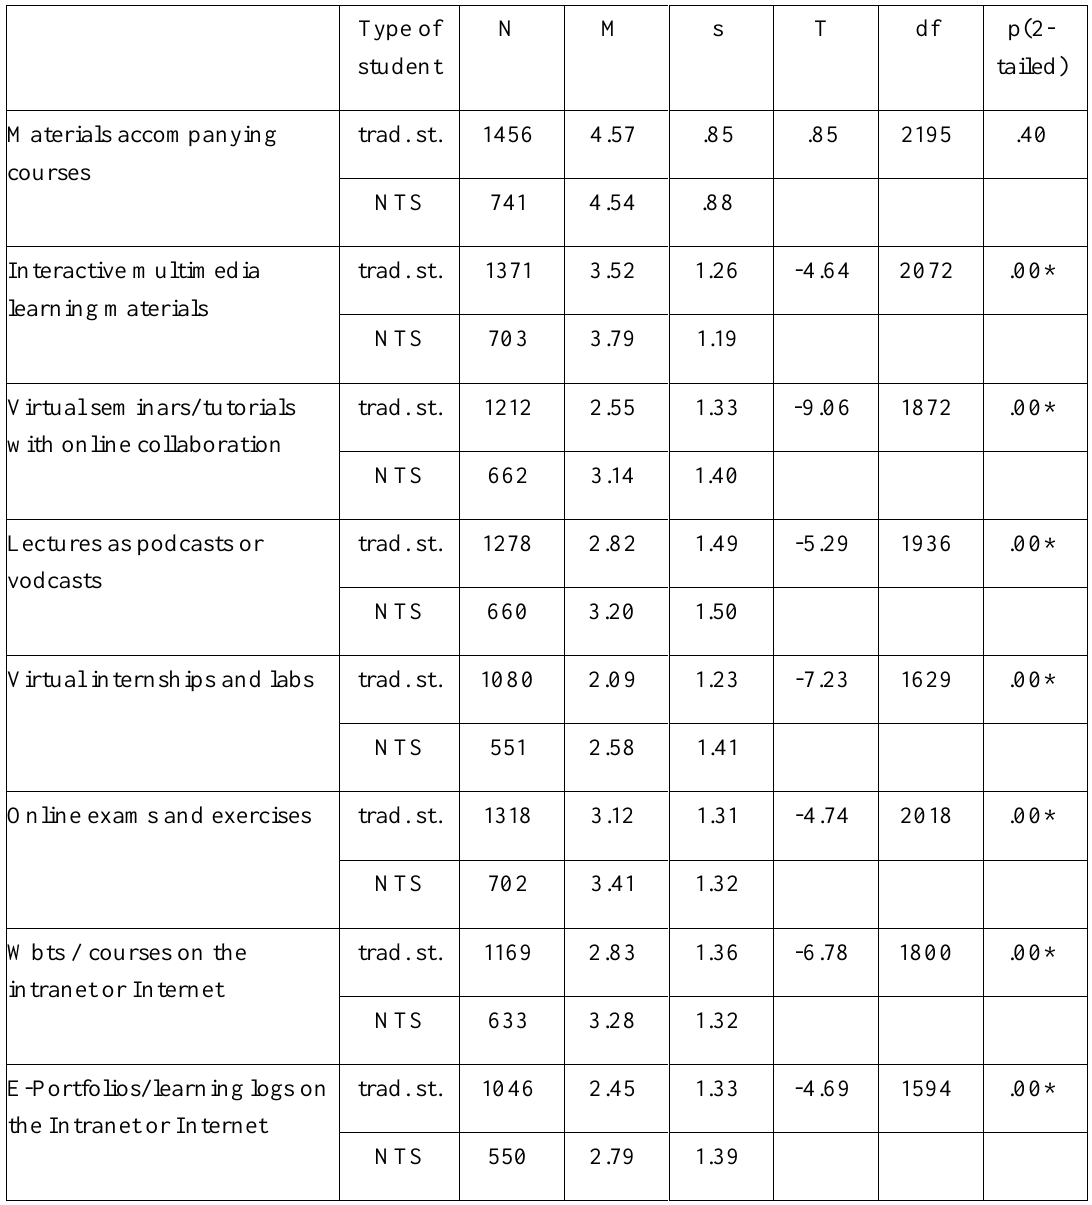
Table 4 Demand for Digital Teaching and Learning Approaches (Comparison of Traditional Students and NTS)